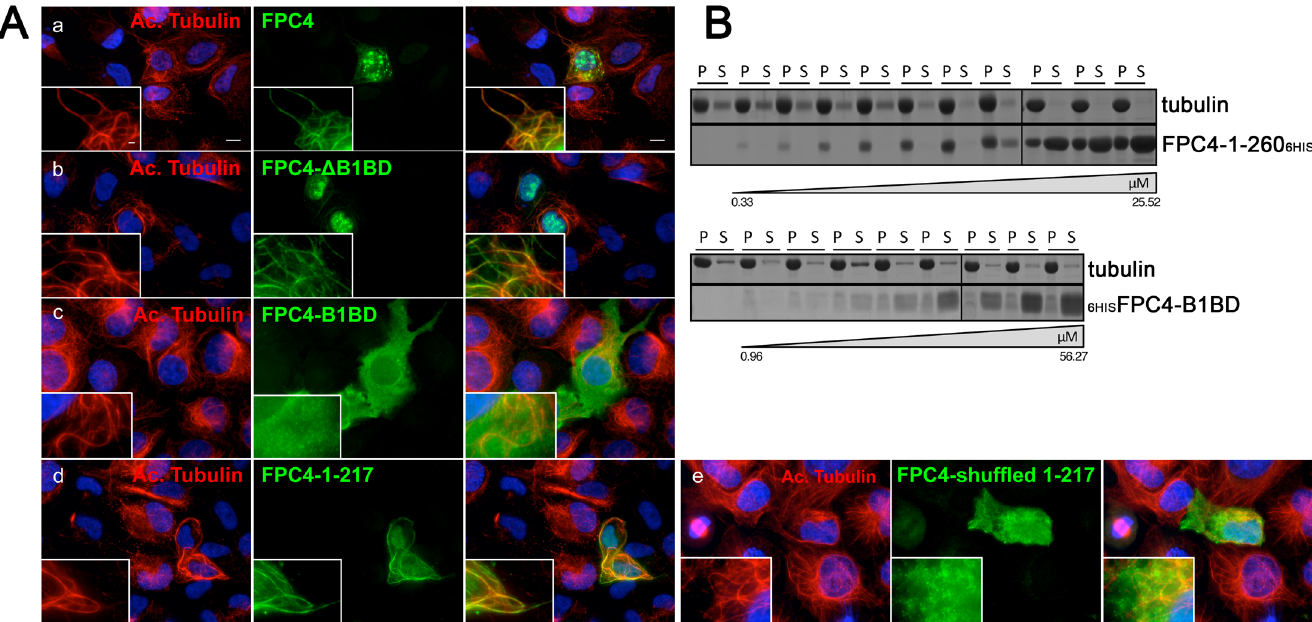
Fig 7. FPC4 is a microtubule binding protein. (A) Anti-acetylated tubulin and anti-GFP immunolabellingon U-2 OS cells expressingGFP taggedFPC4 (a), FPC4- Δ B1BD (aa 1–356)(b), FPC4-B1BD(aa 357–444)(c), FPC4-1-217(d), and FPC4-shuffled-1-217(e). Scale bar represents 10 μ m. The transfections were performed more than three independent times. (B) Microtubule bindingassay (n = 3). Increasingconcentrations of purifiedFPC4-1-